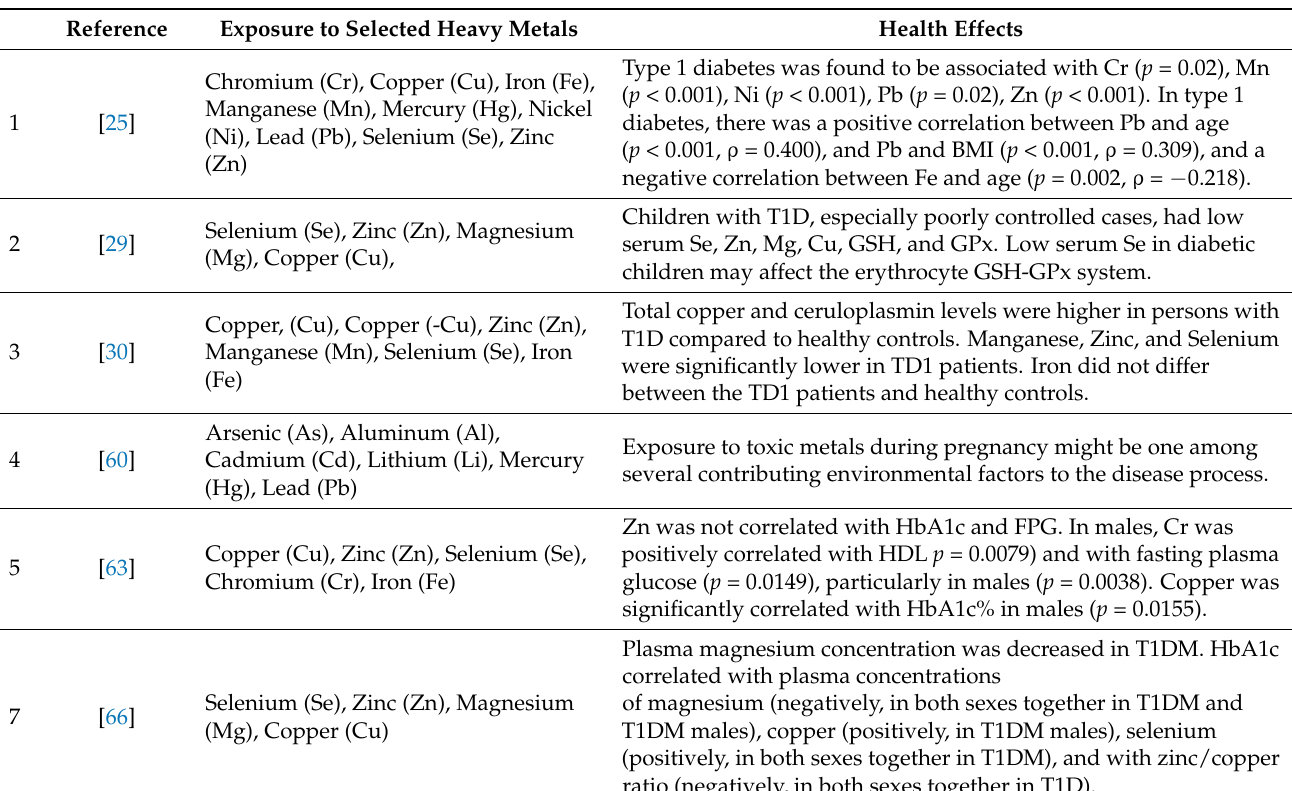
Table 2. The exposure to selected heavy metals and the possible risk of developing type 1